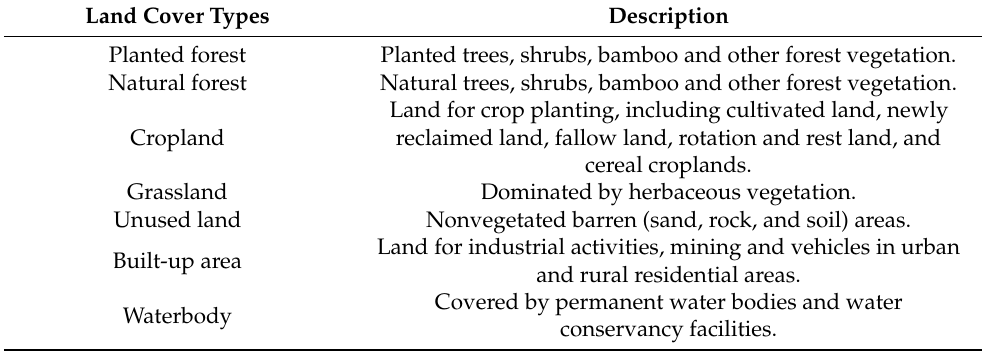
Table A3. Land cover types and class definitions according to the land use/cover classification (LUCC)